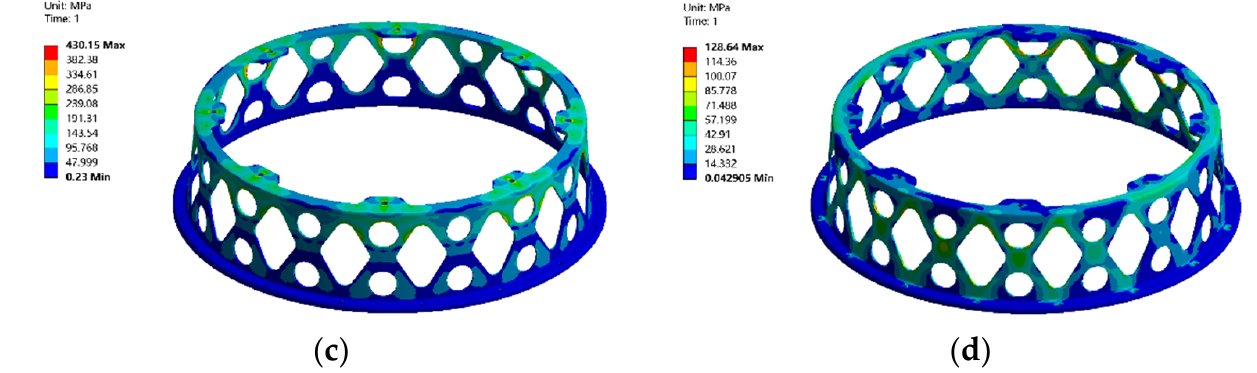
Figure 2. Structural responses of the initial design: ( a ) Displacement distribution in the axial overload case; ( b ) Displacement distribution in the transverse overload case; ( c ) Vonmises stress distribution in the axial overload case; ( d ) Vonmises stress distribution in the transverse overload case.